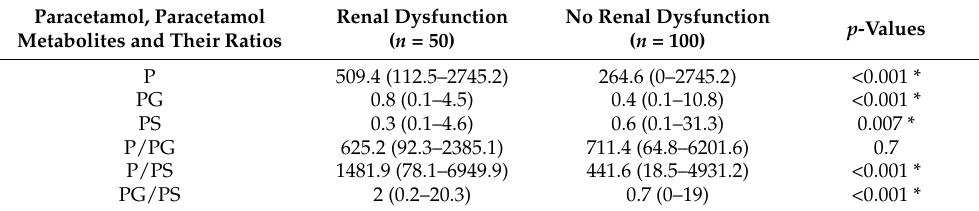
Table 4. Comparison of serum paracetamol, paracetamol metabolites, and metabolite ratios between those with renal dysfunction and those